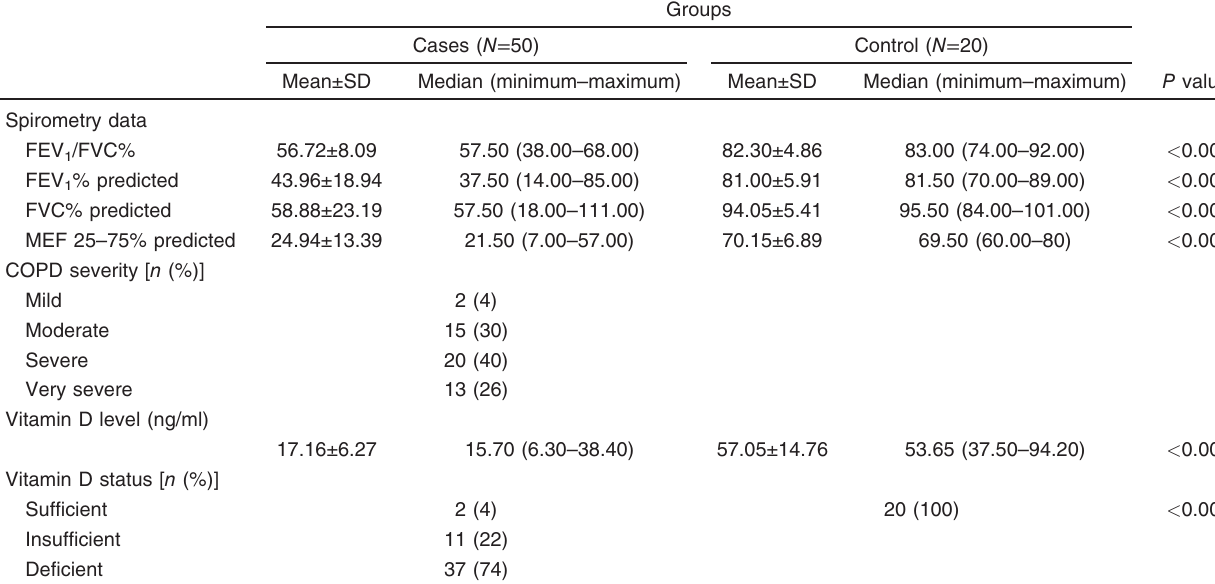
Table 2 Statistical analysis of the functional data, and vitamin D level among chronic obstructive pulmonary disease cases and control group